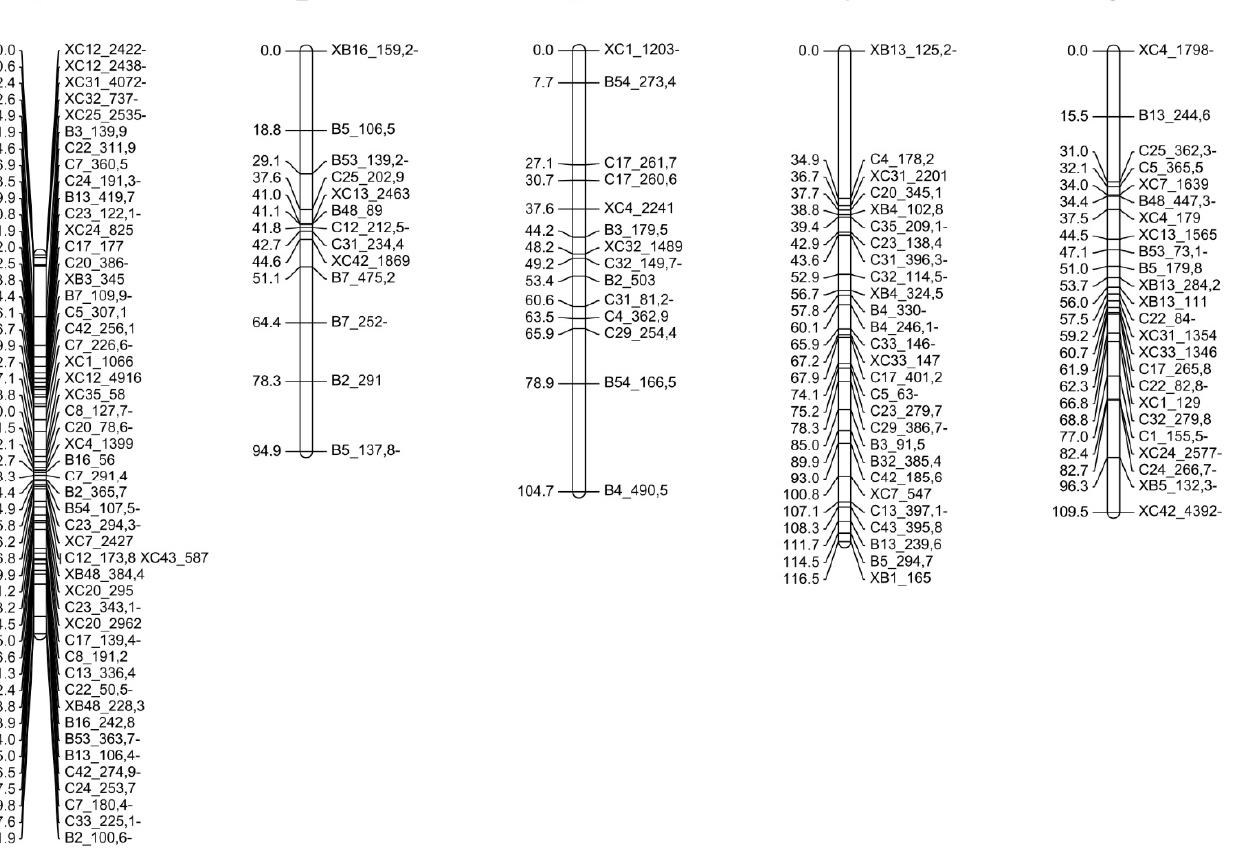
Figure 6. Linkage map of the diploid (2 n = 2 x ) paternal genotype of P. rufum (R5#49). Markers and distances in cM (Kosambi) are indicated on the right and the left respectively. Each co-segregation group includes SDAF and BSDF (starting with an X) markers in coupling and repulsion-phase (-).